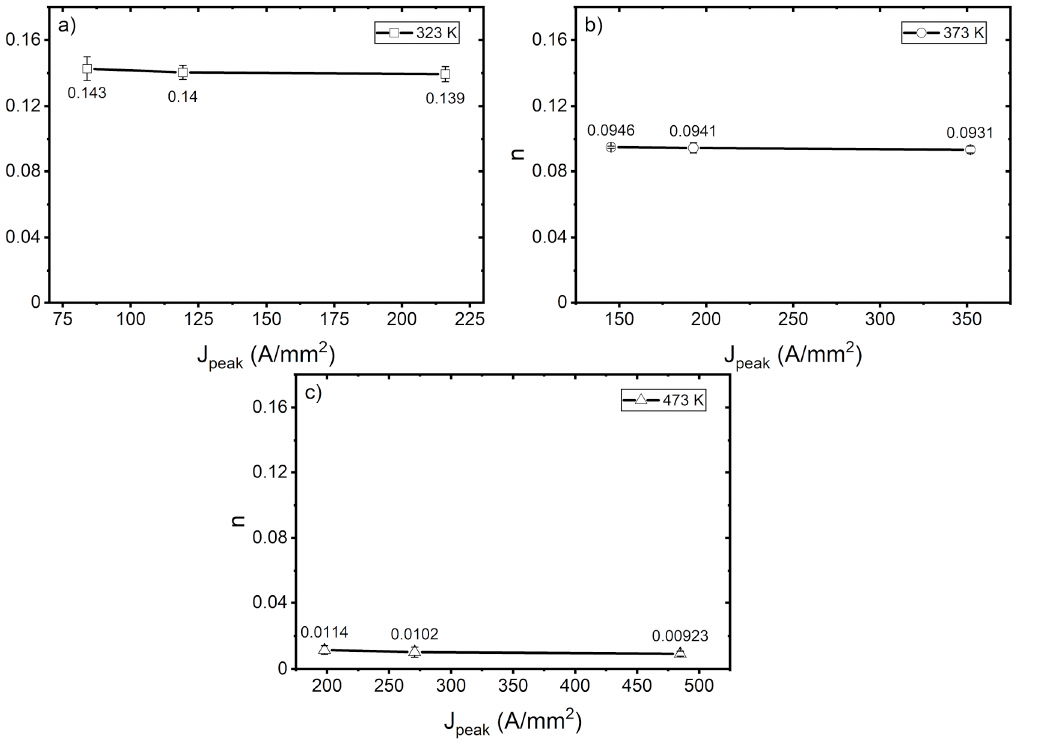
Figure 9. Strain hardening exponent at various peak current densities at ( a ) 323 K, ( b ) 373 K, and ( c ) 473 K.